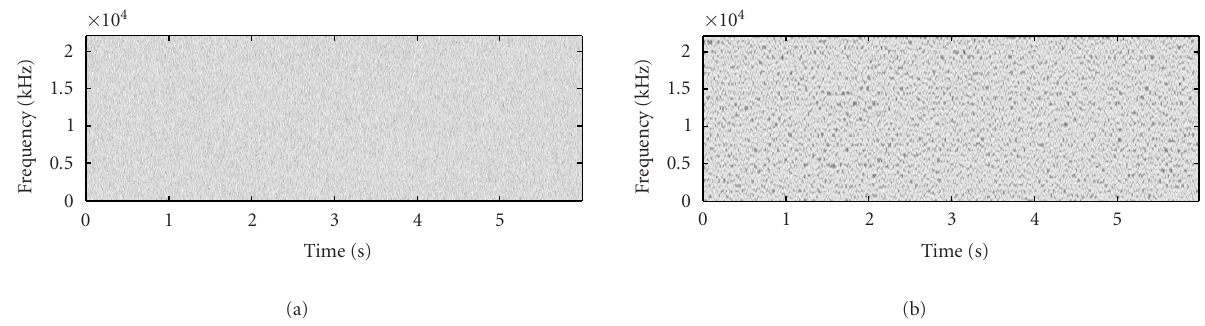
Figure 1: Illustration of the spectral density: spectral di ff erences between (a) Gaussian white noise and (b) white noise whose spectral density is low (synthesized with the CNSS model). The black parts indicate gaps of energy. These gaps are perceived and allow human ears to di ff erentiate these two